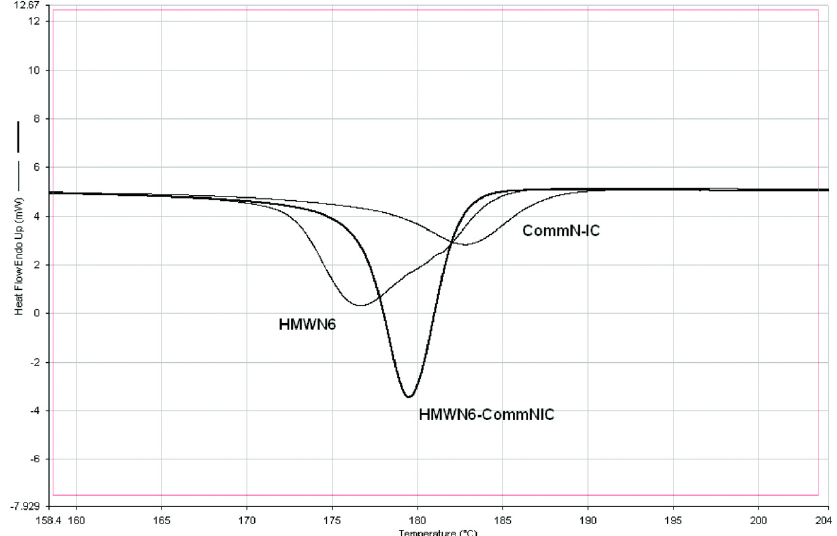
Figure 3. Crystallization on cooling (10 ◦ C/min) melts of neat nylon-6 (HMWN6), 3:1 (n-s) nylon-6– α –CD IC (CommN-IC), and nylon-6 with 2 wt % of 3:1 (n-s) nylon-6– α –CD IC (HMWN6-CommNIC). In each case, nylon-6 with MW = 60,000 was employed, reproduced from [8] with permission, copyright American Chemical Society,